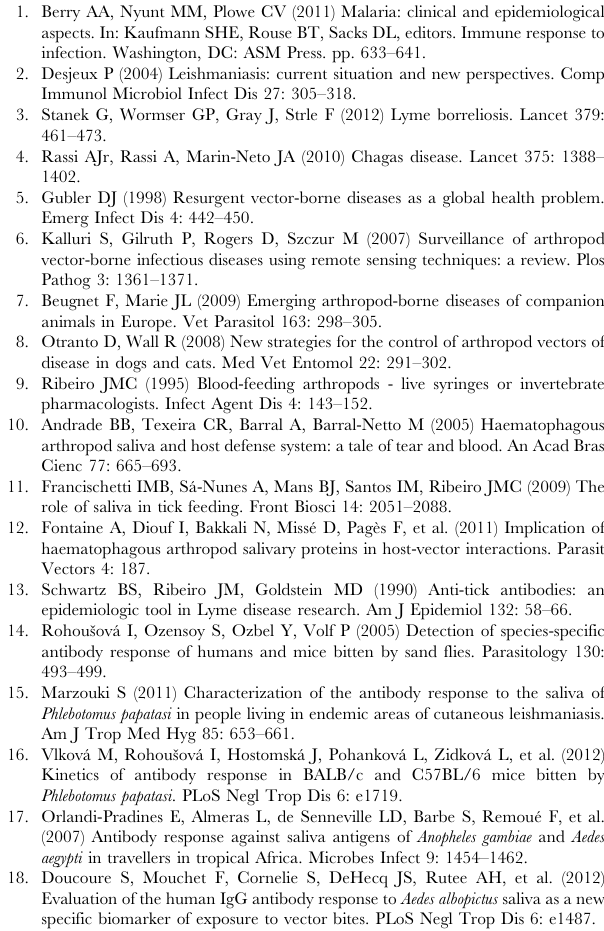
Figure S3 2D salivary profile and western blot analyses of nymphal and adult T. infestans from Peru. Saliva of 5 th instar nymphs (5 th instar, A) and adults (females and males, E) Peruvian T. infestans were isoelectrically focused in the nonlinear pH range of 3–11. Black circles indicate nymphal (A) or adult (E) specific salivary proteins. In order to improve the protein separation, saliva of nymphs (B) and adults (F) were isoelectrically focused in the nonlinear pH range of 3–5.6 and blotted onto nitrocellulose. Comparing IgG (C, G) and IgM antibody reactions (D, H) with salivary proteins of nymphs (C, D) and adults (G, H) T. infestans saliva, the candidate exposure marker antigen of 35 kDa was recognized by IgG and IgM antibodies of guinea pig serum